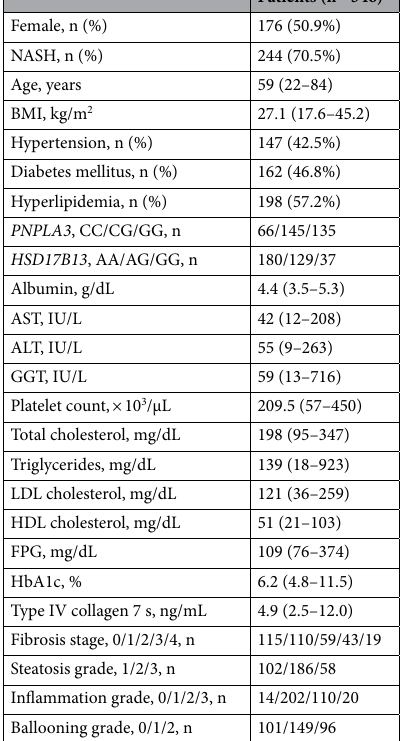
Table 1. Patient characteristics. BMI body mass index, AST aspartate aminotransferase, ALT alanine aminotransferase, GGT gamma-glutamyl transferase, LDL low-density lipoprotein, HDL high-density lipoprotein, FPG fasting plasma